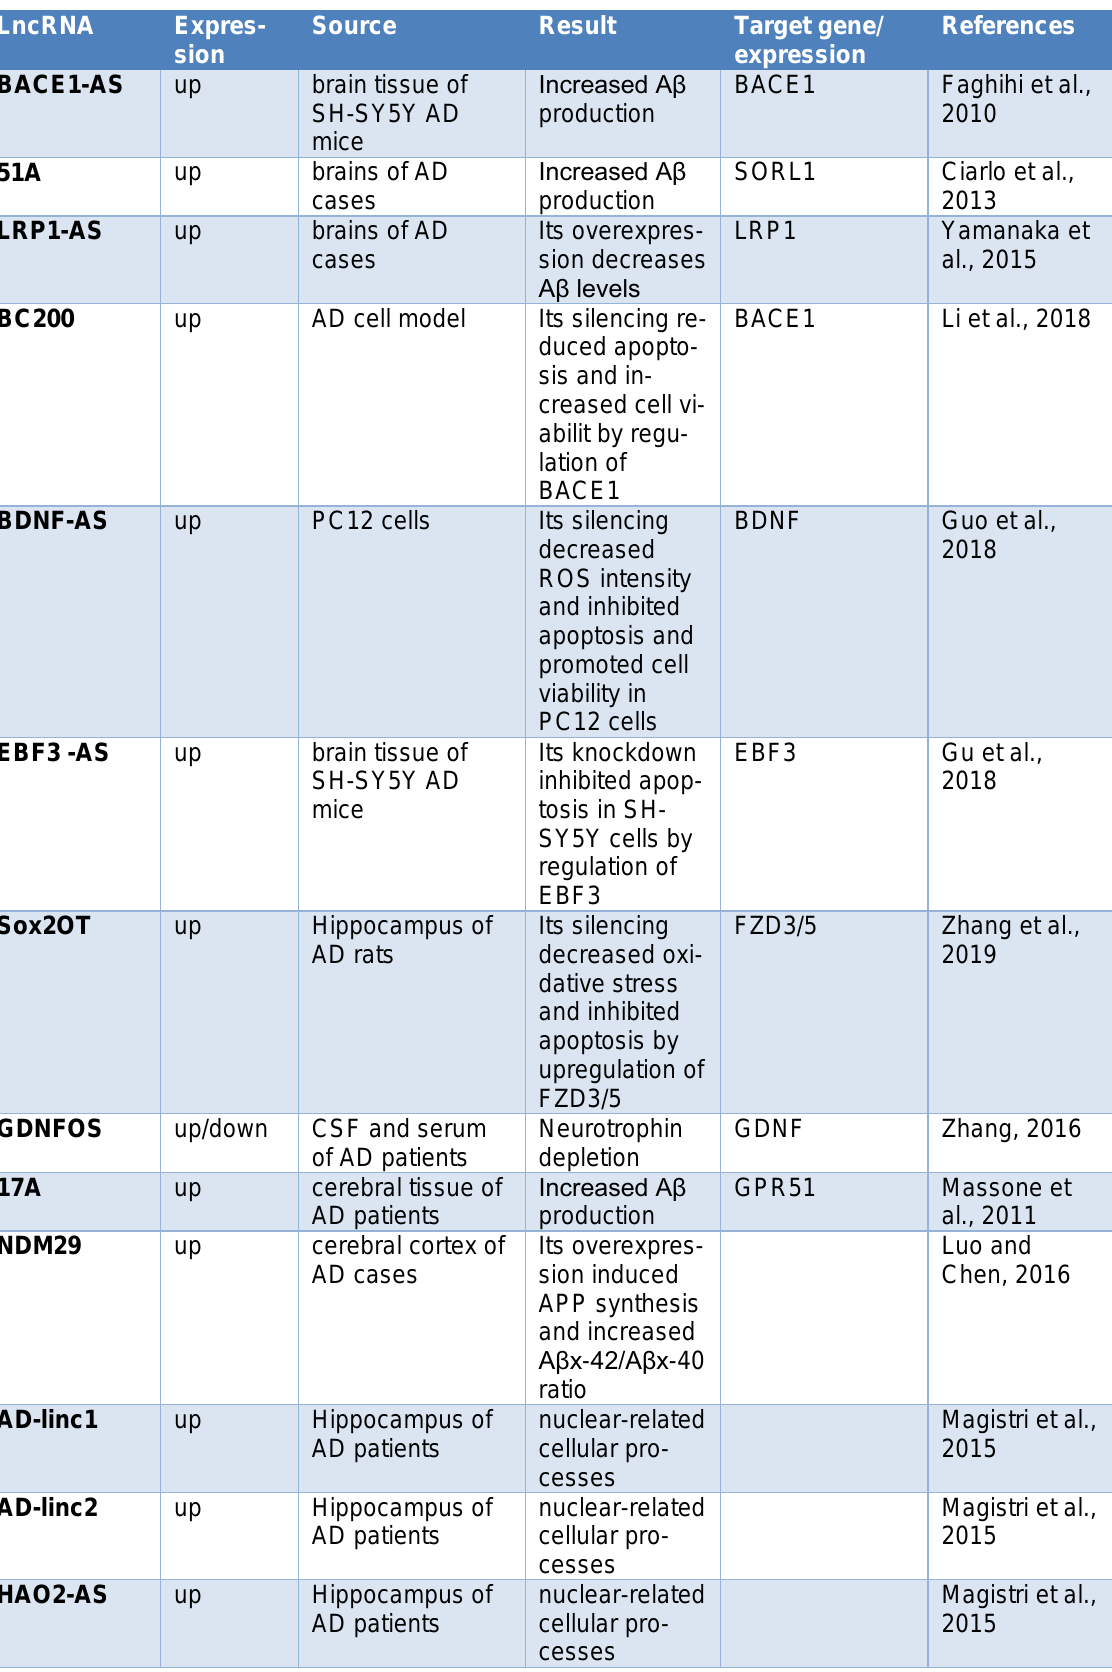
Table1: The lncRNAs involved in Alzheimer's disease